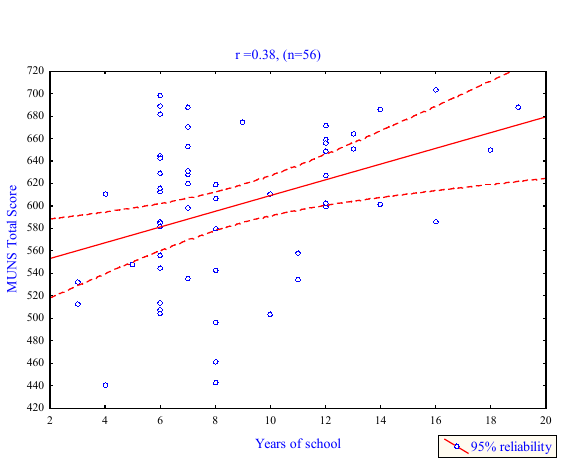
Figure 1. Correlation between MUNS total score and years of school.